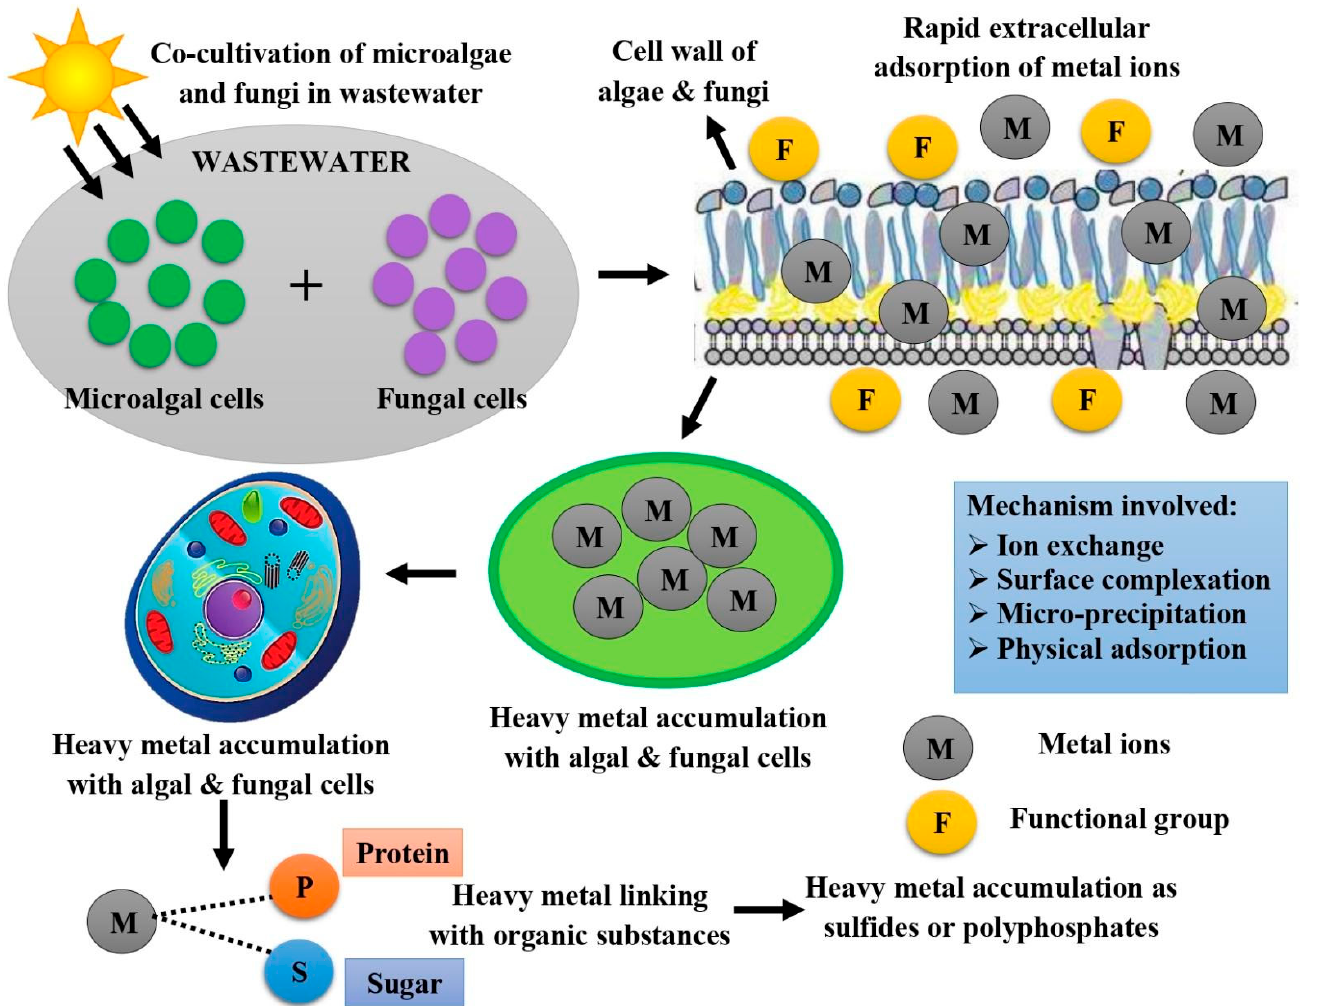
Figure 6. Removal of heavy metal ions from wastewater by utilizing a microalgae–fungi consortium.